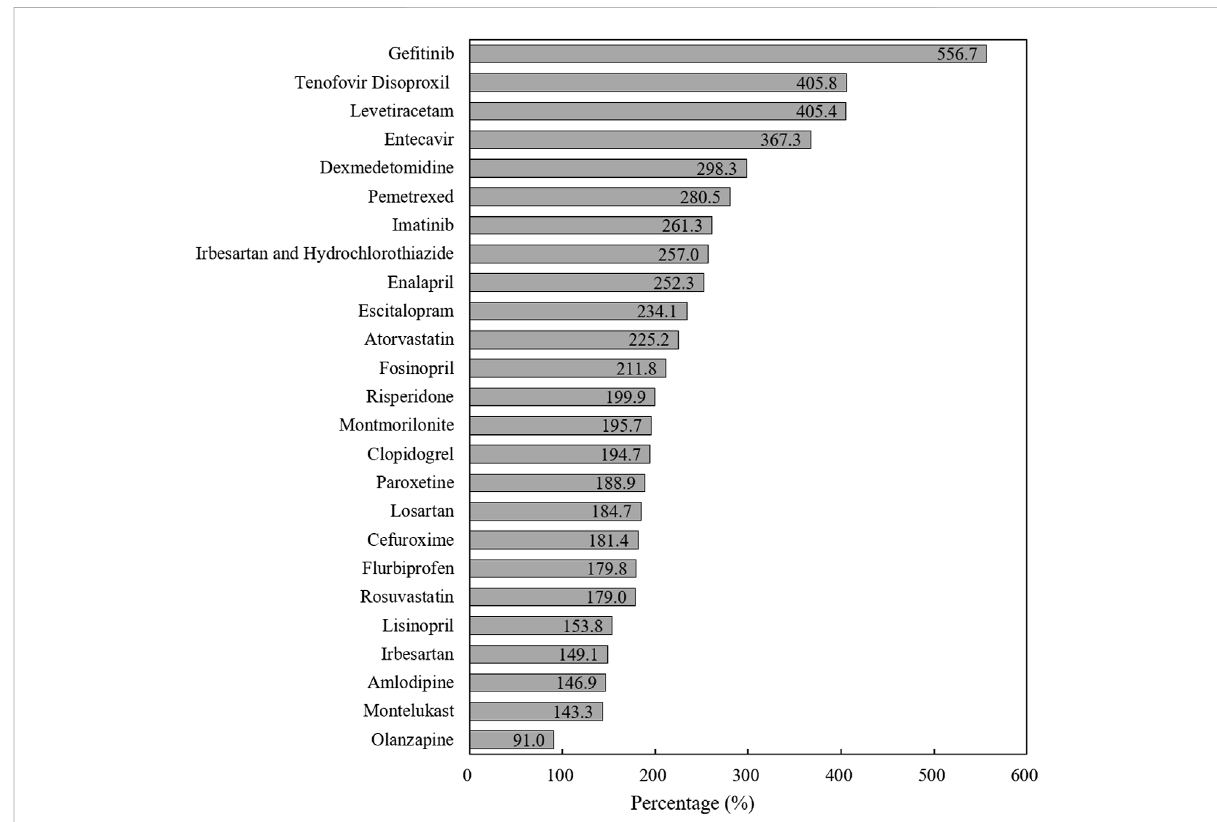
FIGURE 3 The completion rate of agreed procurement quantity of each “ 4 + 7 ” List drug during one-year agreement period.